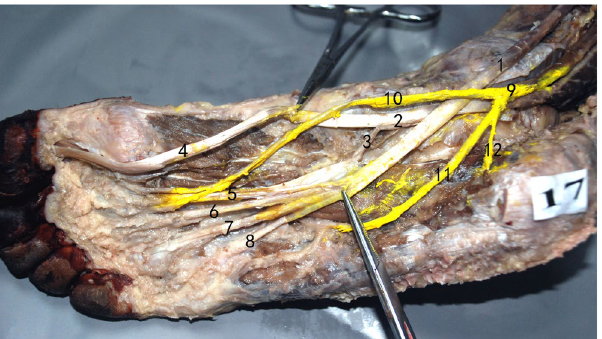
Figure 5. Type I (1). FDL tendon, (2). FHL tendon, (3). a tendinous slip is directed from the FHL tendon to the FDL tendon, (4). first (1 st ) long flexor tendon, (5). second (2 nd ) long flexor tendon, (6). third (3 rd ) long flexor tendon, (7). fourth (4 th ) long flexor tendon, (8). fifth (5 th ) long flexor tendon, (9). tibial nerve, (10). medial plantar nerve, (11). lateral plantar nerve, (12). calcaneal branch.